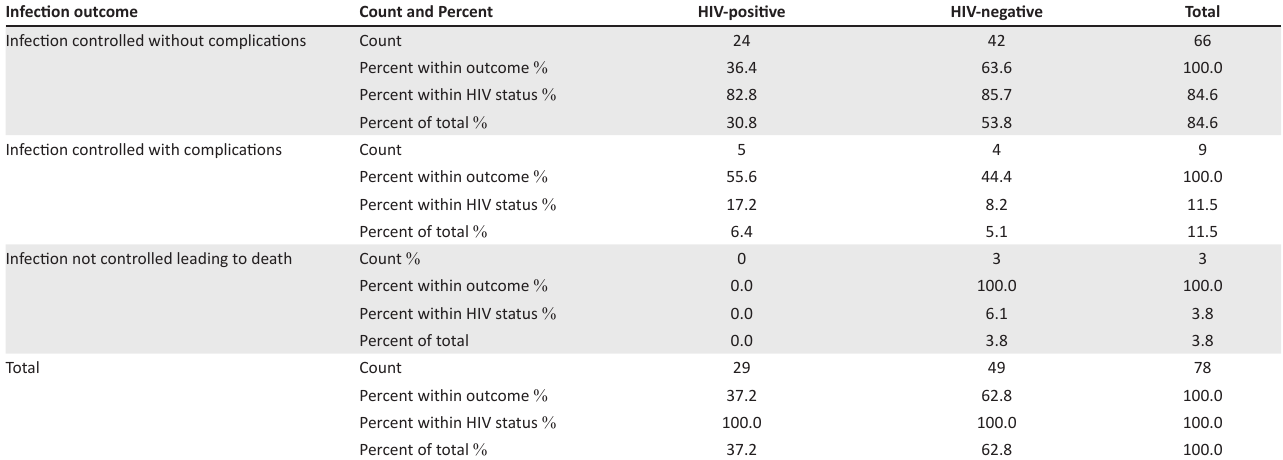
TABLE 5: Treatment outcomes of bacterial infection: HIV-positive versus HIV-negative.